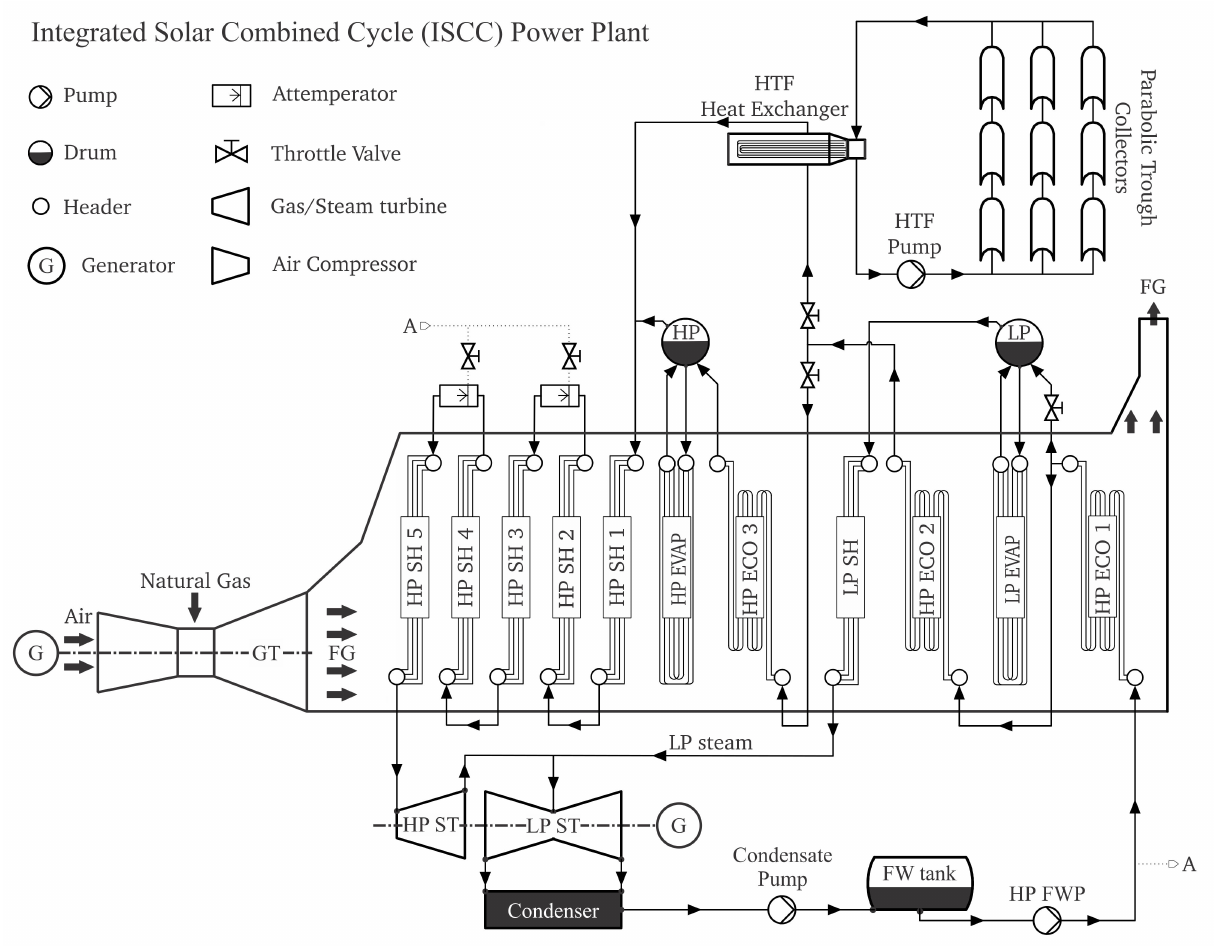
Figure 1. Schematic diagram of the Kuraymat ISCC power